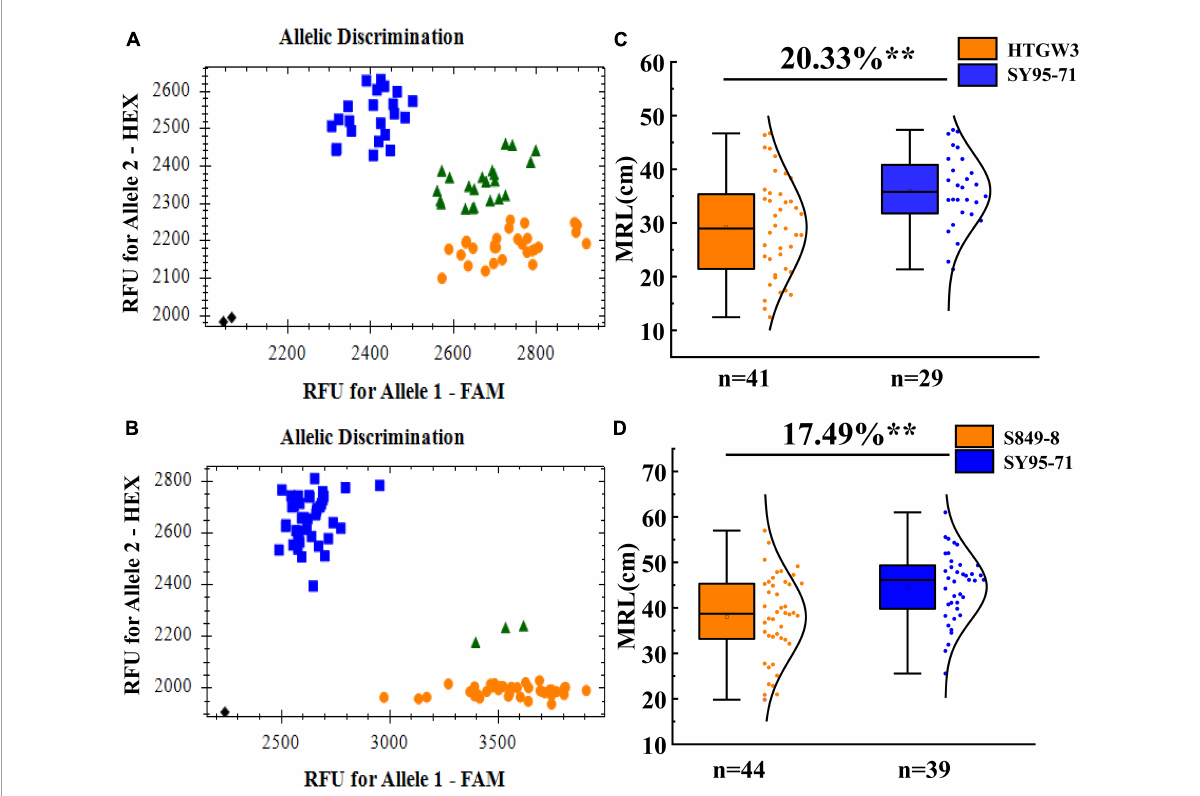
FIGURE6 Validation of QMrl.sicau-2SY-3D.2 in two populations with different genetic backgrounds. Blue round represents lines with the allele of SY95-71 (FAM fluorescence), orange box frame represents lines with the allele of HTGW3 (A) and S849-8 (B) (HEX fluorescence). Fluorescence PCR typing part results of the Kompetitive Allele-Specific PCR (KASP) marker KASP -AX-111589572 in HTG3SY (A) and SSY (B) population. Effects of QMrl.sicau-2SY-3D.2 in two validation populations of HTG3SY (C) and SSY (D) population. ** represents significance at the 0.01